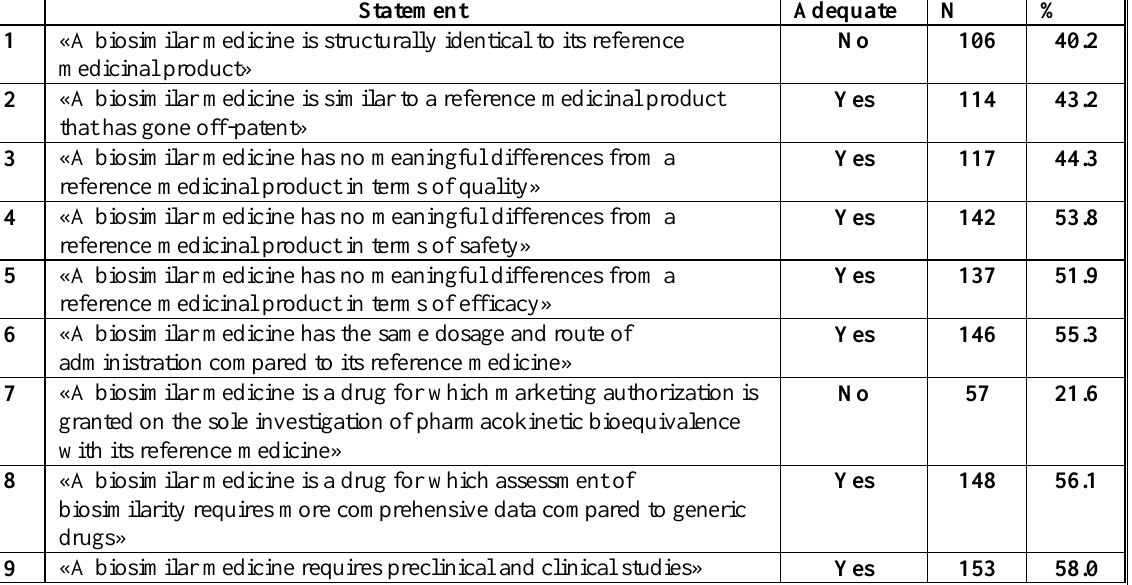
Table 2. Pharmacists’ knowledge about biosimilar